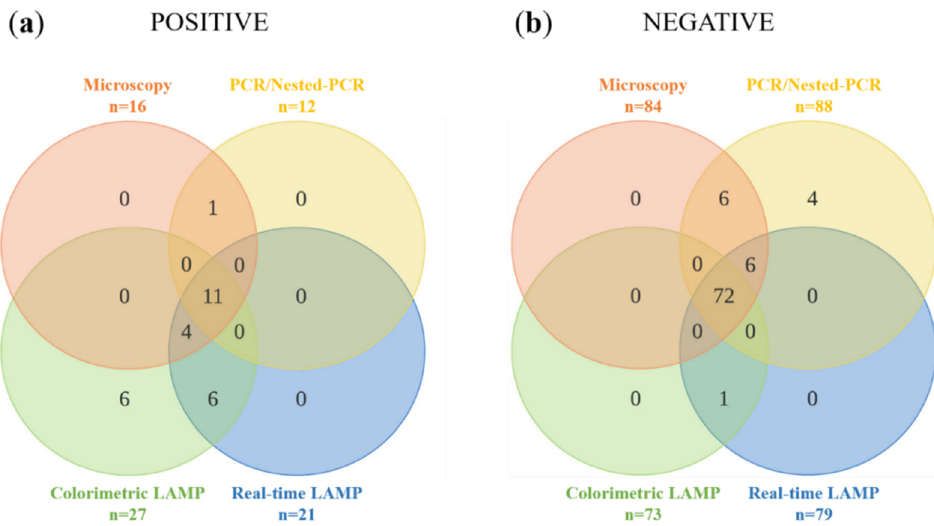
Figure 4. Venn diagrams for four-way comparison of microscopy, colorimetric LAMP, real-time LAMP and PCR/nested-PCR results in specific Loa loa detection: ( a ) Distribution of the samples with a Loa loa positive results for at least one test. ( b ) Distribution of the samples with a Loa loa negative result for at least one test. Table 2. Estimation of the accuracy of the molecular methods applied as diagnostic tests for Loa loa . Estimation of sensitivity, specificity, positive and negative predictive values and Kappa index by DNA amplification tests (colorimetric LAMP, real-time LAMP and PCR/nested-PCR) against mi- croscopy as reference diagnostic method for current study for identifying Loa loa infection in the 100 patients’ dried blood samples analyzed. PPV, positive predictive value; NPV, negative predictive value; CI, confidence intervals; Kappa, Kappa index.